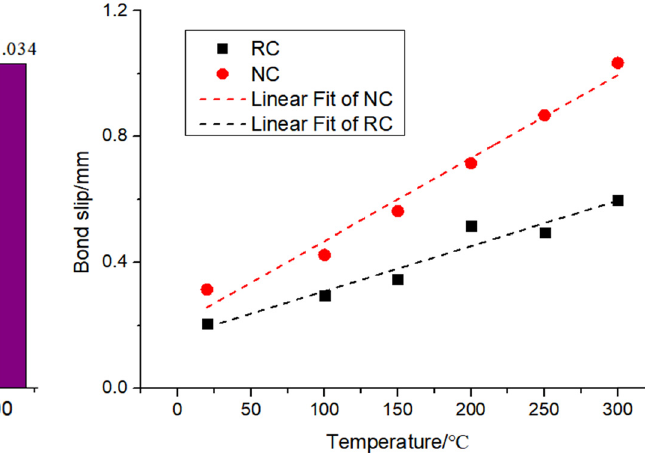
Figure 6: Bond slip after high temperature.